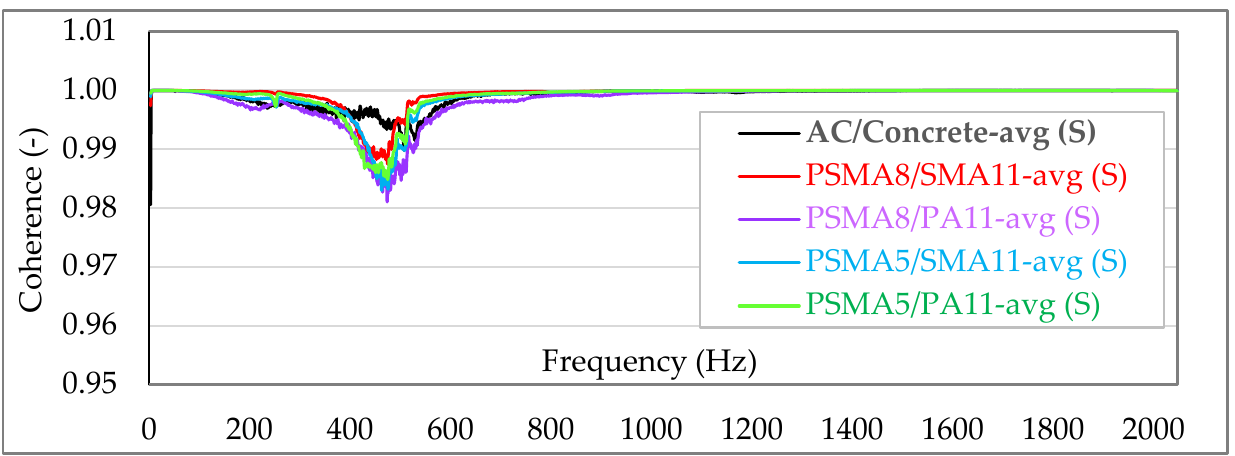
Figure 7. Summary of the coherence for all asphalt mixtures — in situ measurements (S).